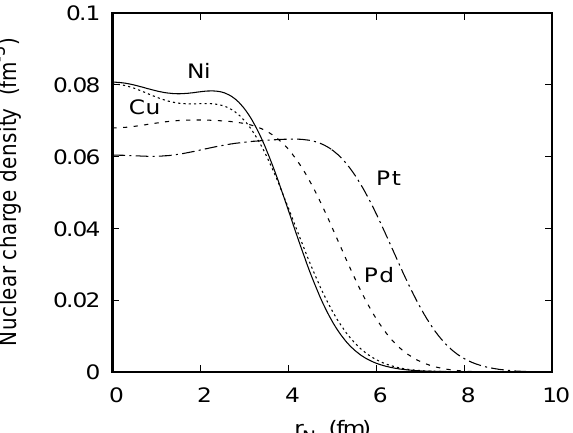
Figure 3. Nuclear charge density ( (cid:36) N ) for Ni 58 (——), Cu 63 ( · · · · · · ) , Pd 108 ( − − −− ) , and Pt 196 ( − · − · − ) as a function of the nuclear coordinate, r N